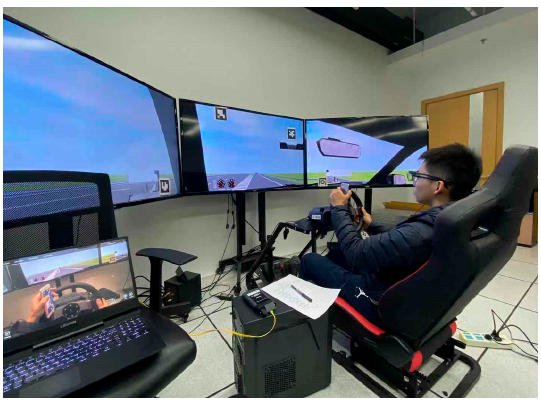
Figure 1. The driving simulation